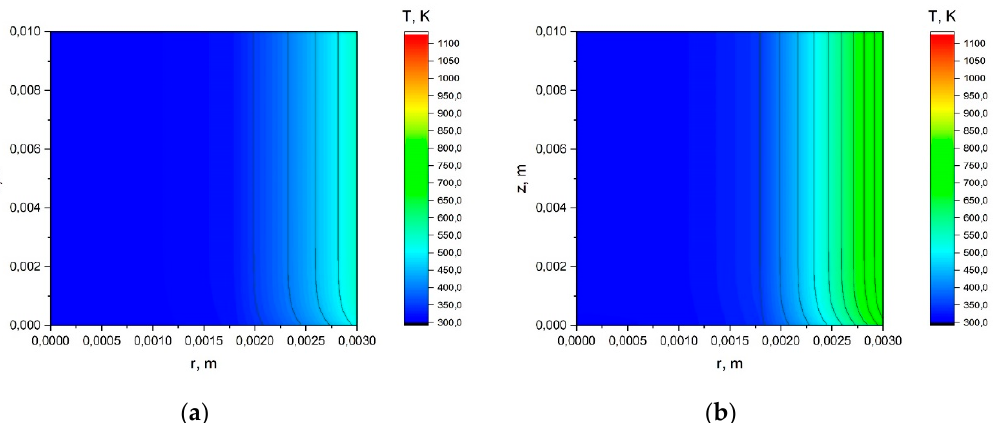
Figure A12. Temperature distribution in the stem of a herbaceous plant: R = 0.003 m, t = 3 s, q = 3 kW / m 2